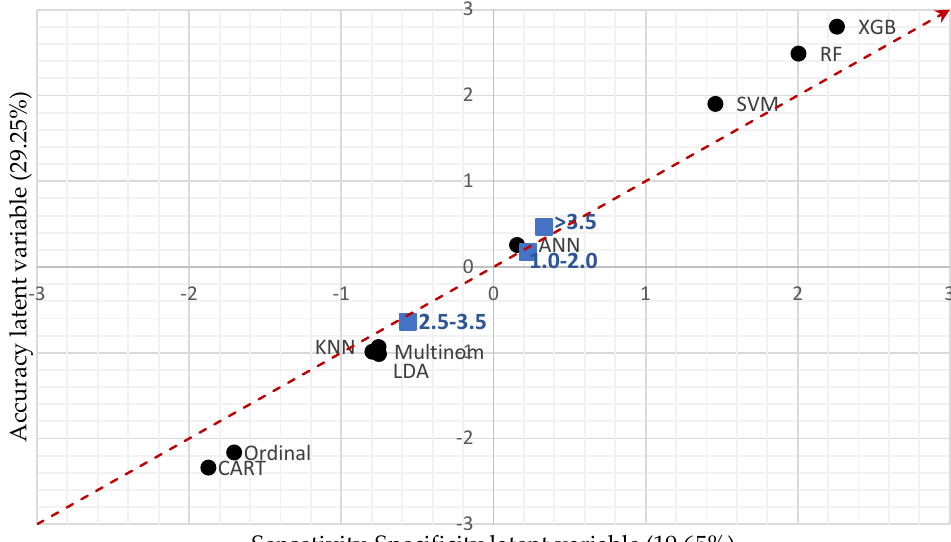
Figure 4. A plot of the accuracy and sensitivity–specificity latent variables from their first dimension/component obtained through a factor analysis of mixed variables (a combination of principle component and multiple correspondence analyses) procedure on measures of performance for the prediction of ewe BCS at pre-lambing. Dots (red sphere: model, blue square: BCS class). Dotted diagonal line indicates a balance between accuracy and sensitivity–specificity. If dot is above, then model or BCS class was more accurate than sensitive–specific while the reverse indicates that the model was more sensitive than accurate. The further and more positive a model is along the diagonal line, the greater and better is its prediction power. The variance explained by each extracted first dimension for each latent variable (accuracy, sensitivity–specificity) is given in parenthesis along the axes.